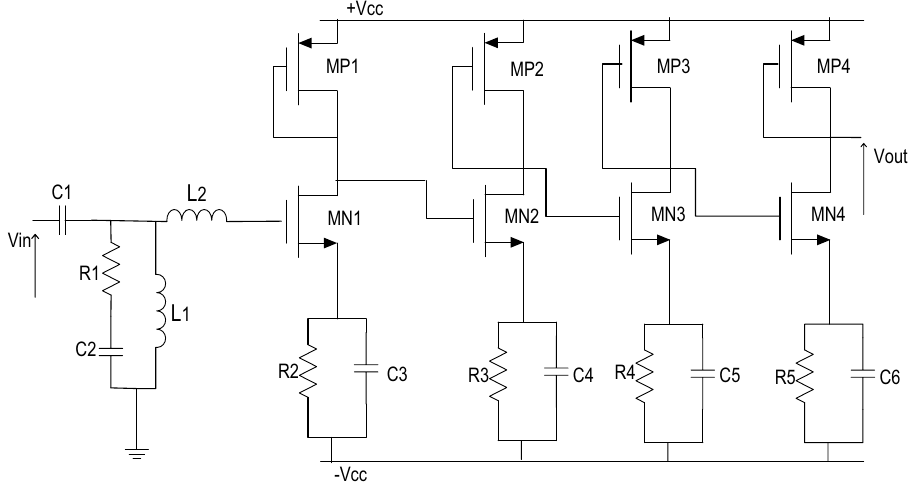
Figure 3. LNA transistor level.